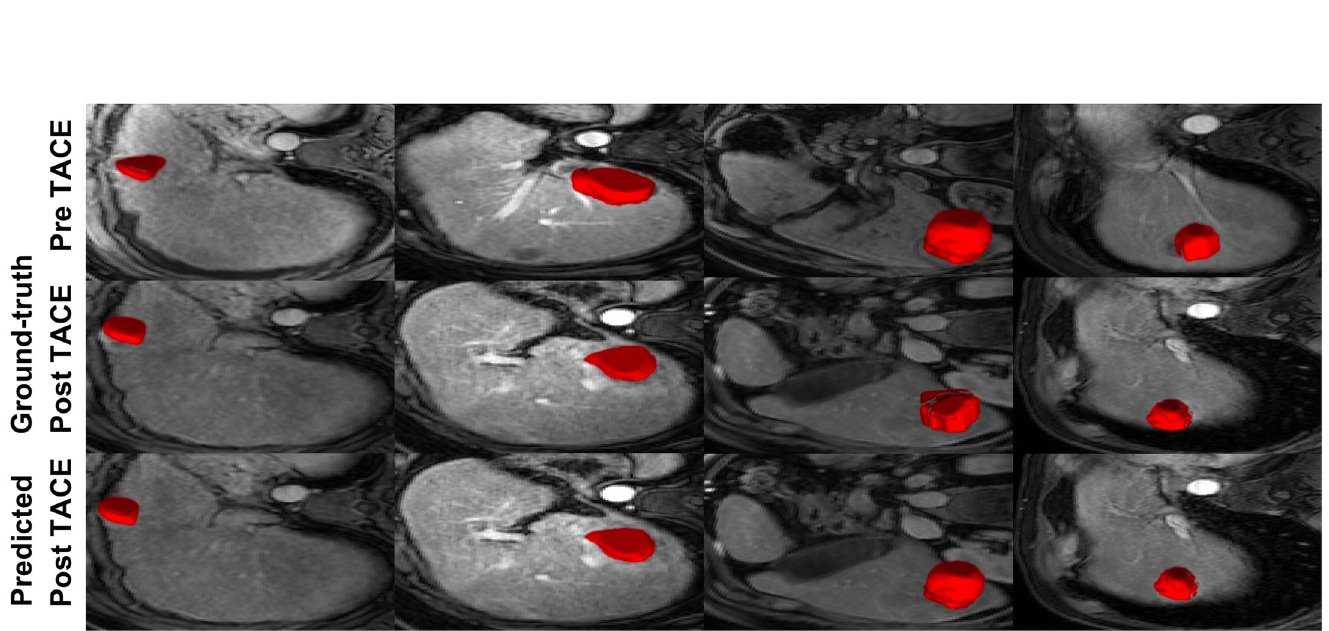
Fig 8. Box-plots of the HCC segmentations from the predicted post-TACE images based on tumor viability class, using the original post- TACE examinations as the reference, and compared to 4 generation methods.